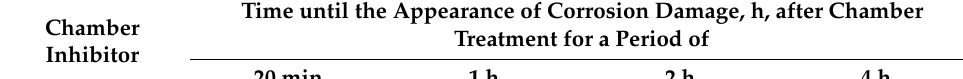
Table 2. PAE of the adsorption films formed on steel in CIN vapors at 120 ◦ C and various τ CT . Recurrent moisture condensation conditions.